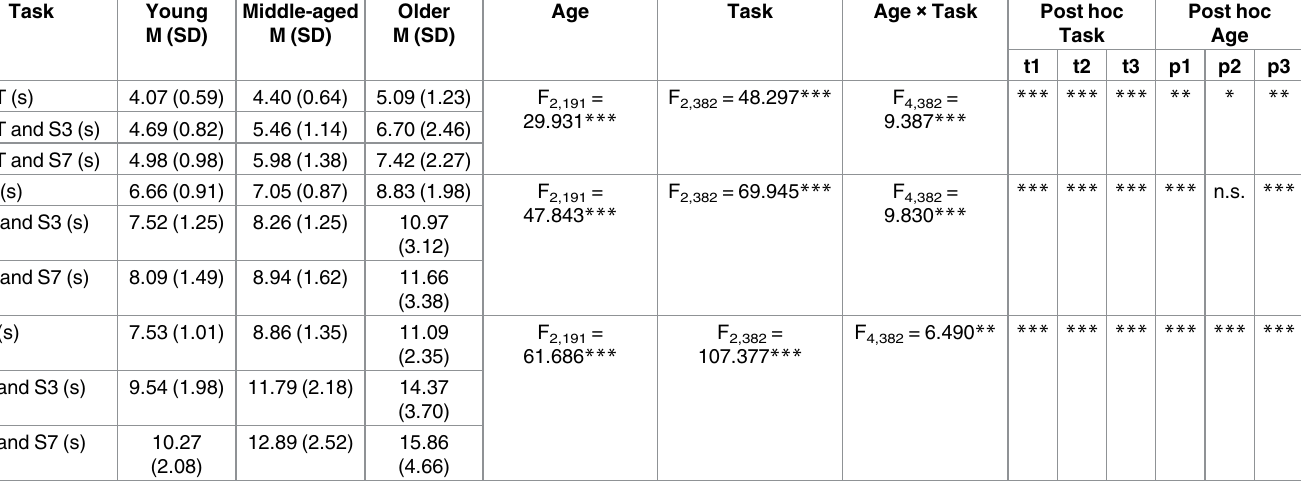
Table 4. ANCOVAsand post hoc results of the mobility performance tests. Task